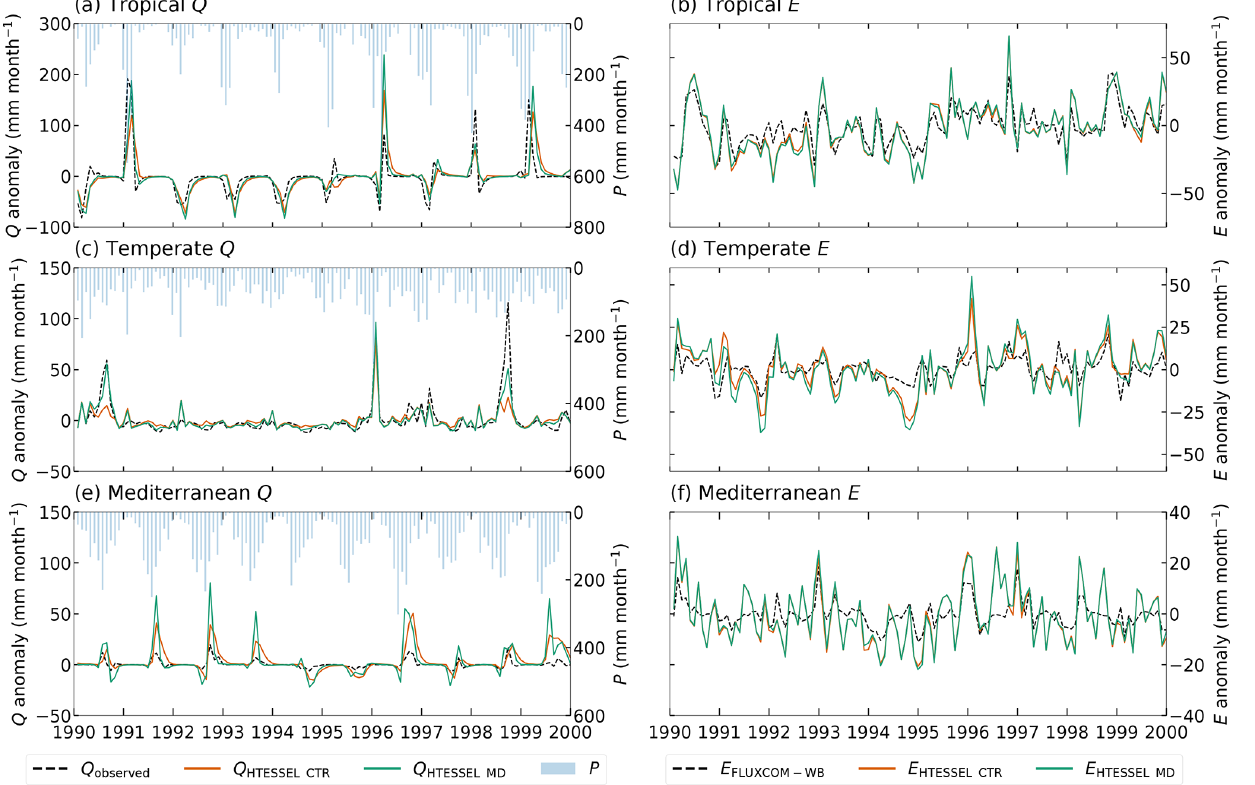
Figure 7. Interannual monthly anomalies of observed discharge ( Q ) (a, c, e) and FLUXCOM-WB evaporation ( E ) (b, d, f) fluxes as well as modeled values in the HTESSEL CTR and MD versions in an individual representative tropical (catchment Mi) (a, b) , temperate (catchment Na) (c, d) and Mediterranean (catchment K) (e, f) catchment based on the time series for 1975–2010. Similar illustrations for the individual catchments are shown in Figs. S1 ( Q ) and S2 ( E ).